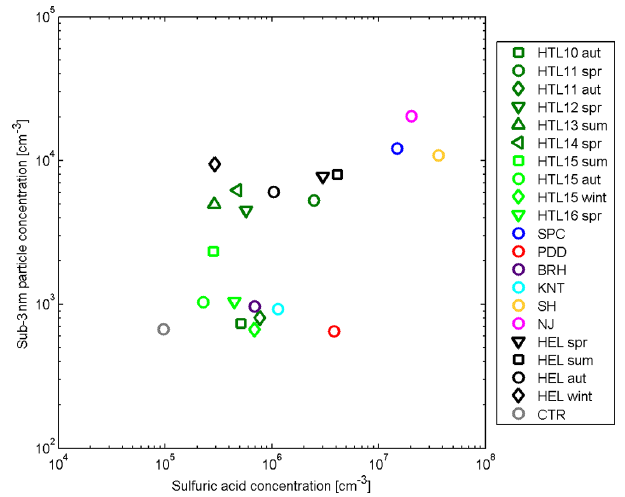
Figure 11. The daytime medians of sub-3nm particle concentration as a function of condensation sink during different measurement